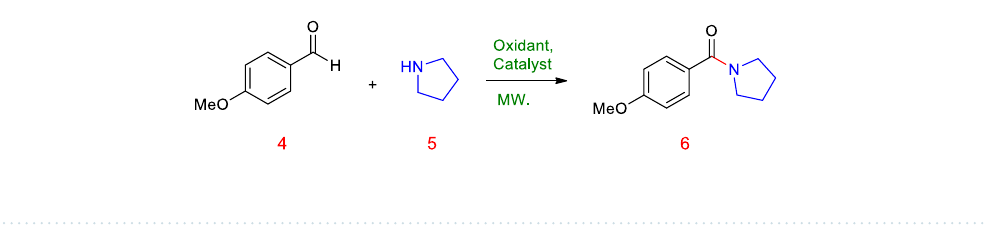
Table 3. Optimization of the reaction conditions of amide synthesis.